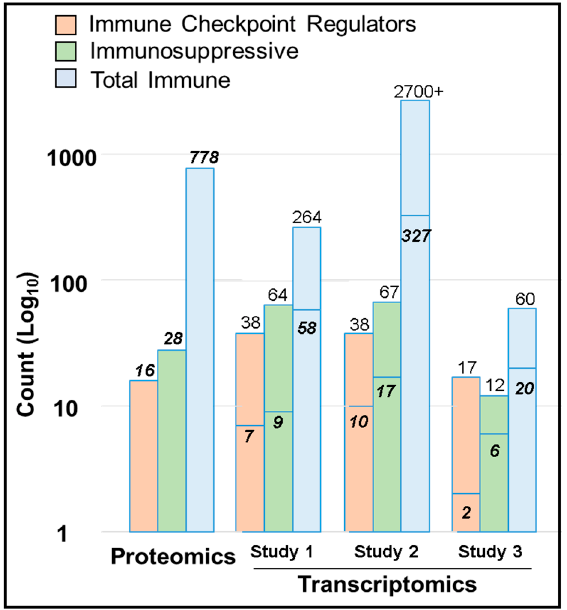
Figure 7. Immune Checkpoint Regulators and Immunosuppressive Proteins. The number of ICRs, immunosuppressive proteins, and total immune proteins quantified by proteomics in pUM is compared with similar immune transcripts reported in three recent transcriptomic studies. Transcriptomic Study 1 (Figueiredo et al. 2000) data is from pUM only; Transcriptomic Study 2 (Durante et al. 2000) includes data from both pUM and liver mUM; and Study 3 (Krishna et al. 2000) data is from liver mUM only.